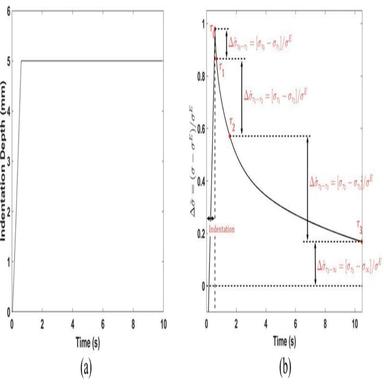
(a) Indentation Profile and (b) Resulting relaxation profile with estimated QLV parameters.